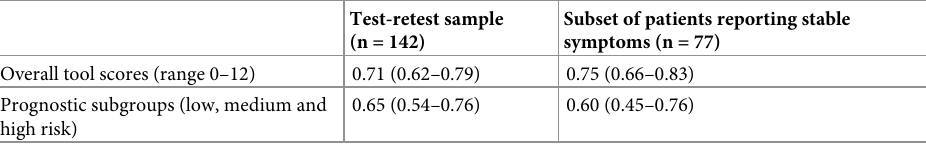
Table 3. Quadratic-weighted kappa for the Dutch STarT MSK tool �